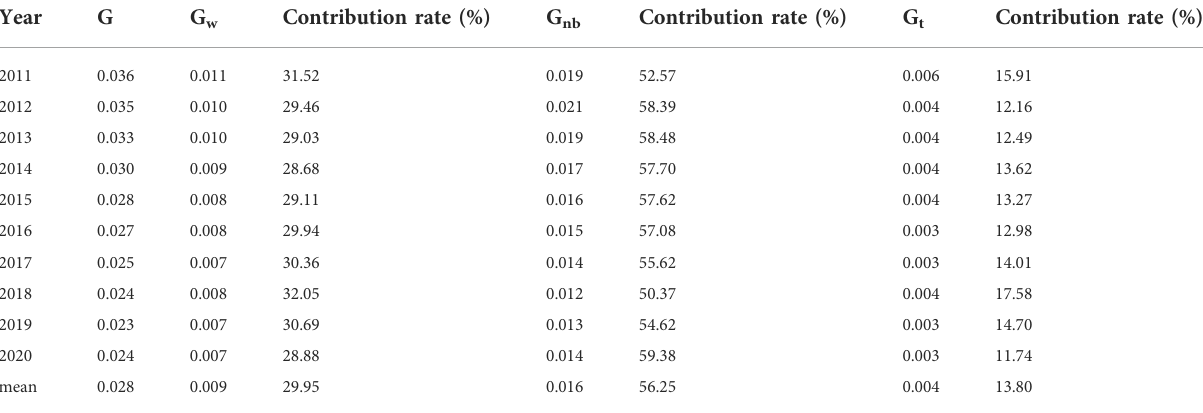
TABLE 3 Overall differences in the level of high-quality economic development of the three major urban agglomerations in the Yangtze River Economic